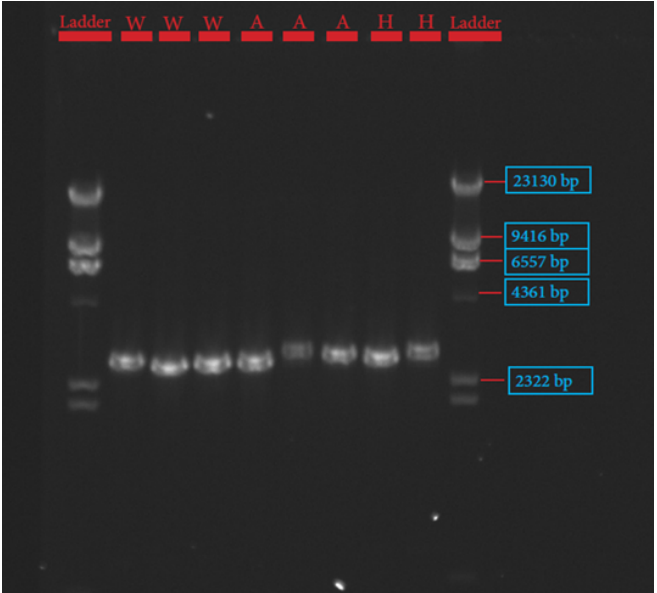
Figure 3. Gel image of fatty acid binding protein ‐ 4 (FABP4) gene. Table 1. Primer pairs and sequences for SCD, FASN, and FABP4 genes for polymerase chain reaction assays.